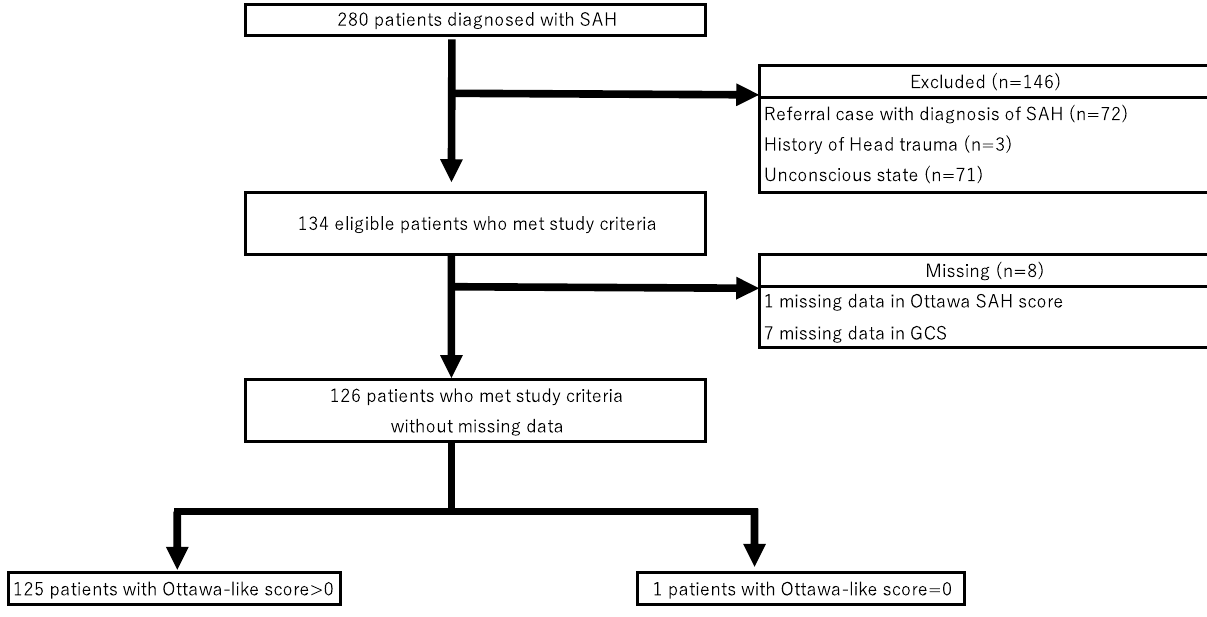
Figure 2. Flow diagram for the validation study of the Ottawa-like rule. GCS=Glasgow Coma Scale, SAH=subarachnoid hemorrhage.